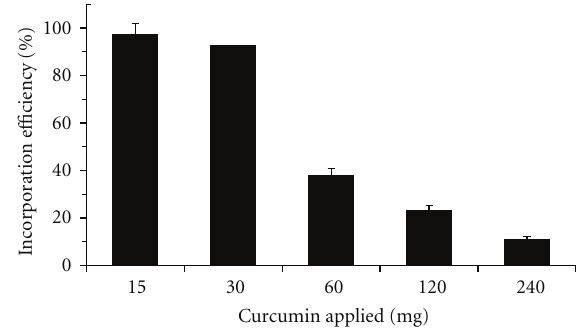
Figure 6: E ff ect of the amount of curcumin applied on the percent incorporation e ffi ciency (% IE) in formulations 1, 5 to 8. Data are the mean ± standard deviation of 3 independent experiments ( n = 3).